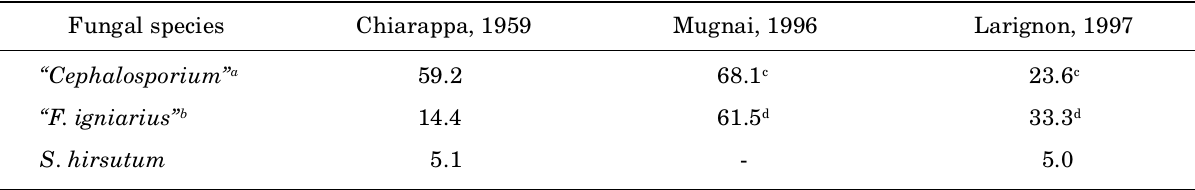
Table 1. Comparison of the isolation frequencies of the fungi from esca diseased vines in California, Italy and France. Isolations in average